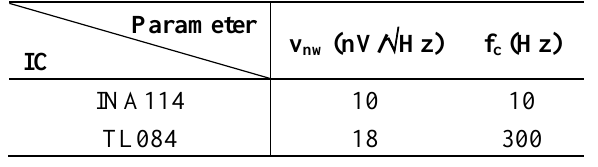
Table 14. Configuration set and related parameters for the noise analysis.